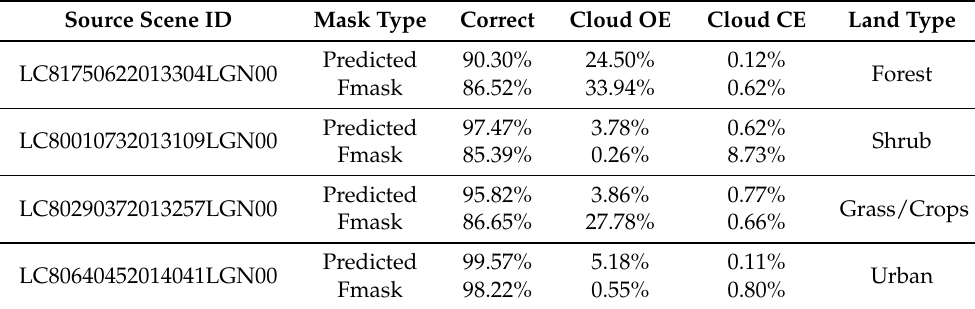
Table 4. Model predicted mask and Fmask accuracy comparison at image level for Figure 5. OE refers to omission error and CE refers to commission error.